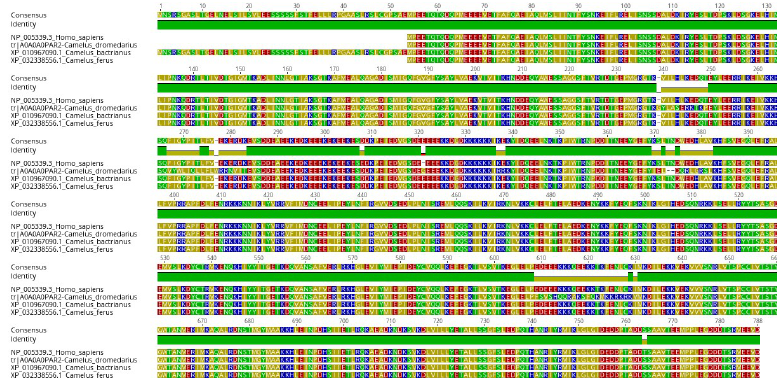
Figure 3. Multiple sequence alignment of four homologous proteins for Homo sapiens , Camelus dromedarius , Camelus bactrianus , and Camelus ferus .